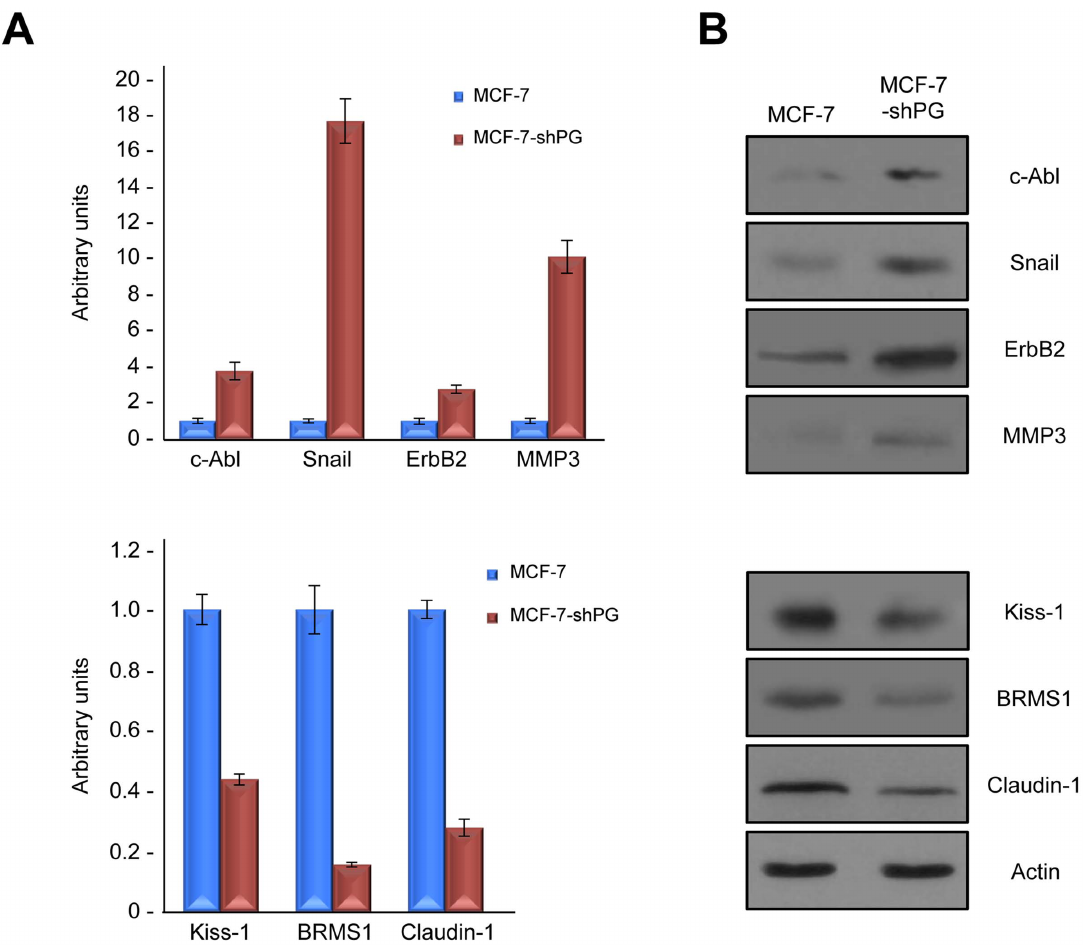
Figure 4. Plakoglobin knockdown changes the levels of SATB1 target genes. A. Total cellular RNA was isolated from MCF-7 and MCF-7- shPG cells, reverse transcribed and processed for PCR using primers specific to SATB1 target genes c-Abl, MMP3, ErbB2, Snail, BRMS1, Kiss1 and Claudin-1. B. Equal amounts of total cellular proteins from these cells were resolved by SDS-PAGE and processed for immunoblotting with antibodies to c-Abl, MMP3, ErbB2, Snail, BRMS1, Kiss1 and Claudin-1. PG, plakoglobin.